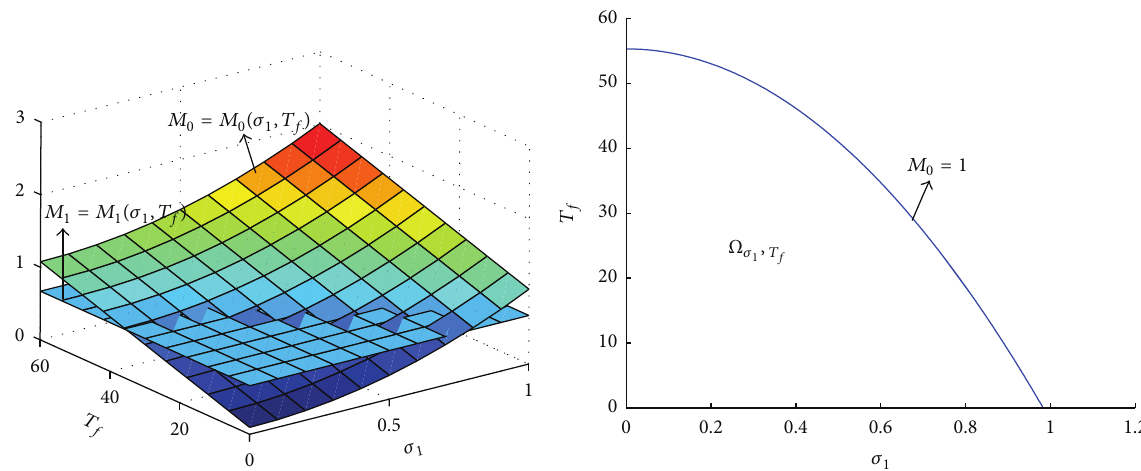
Figure 5: The positive equilibrium 𝐸 ∗ is stochastically stable provided that (𝜎 1 ,𝑇 𝑓 ) ∈ Ω 𝜎